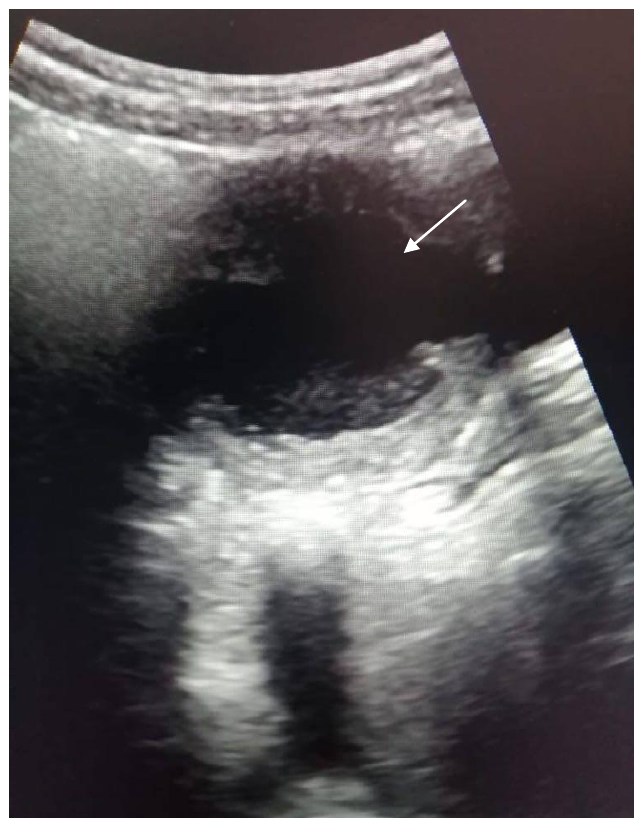
Figure 1 : The functional rudimentary non-communicating uterus under ultrasound.